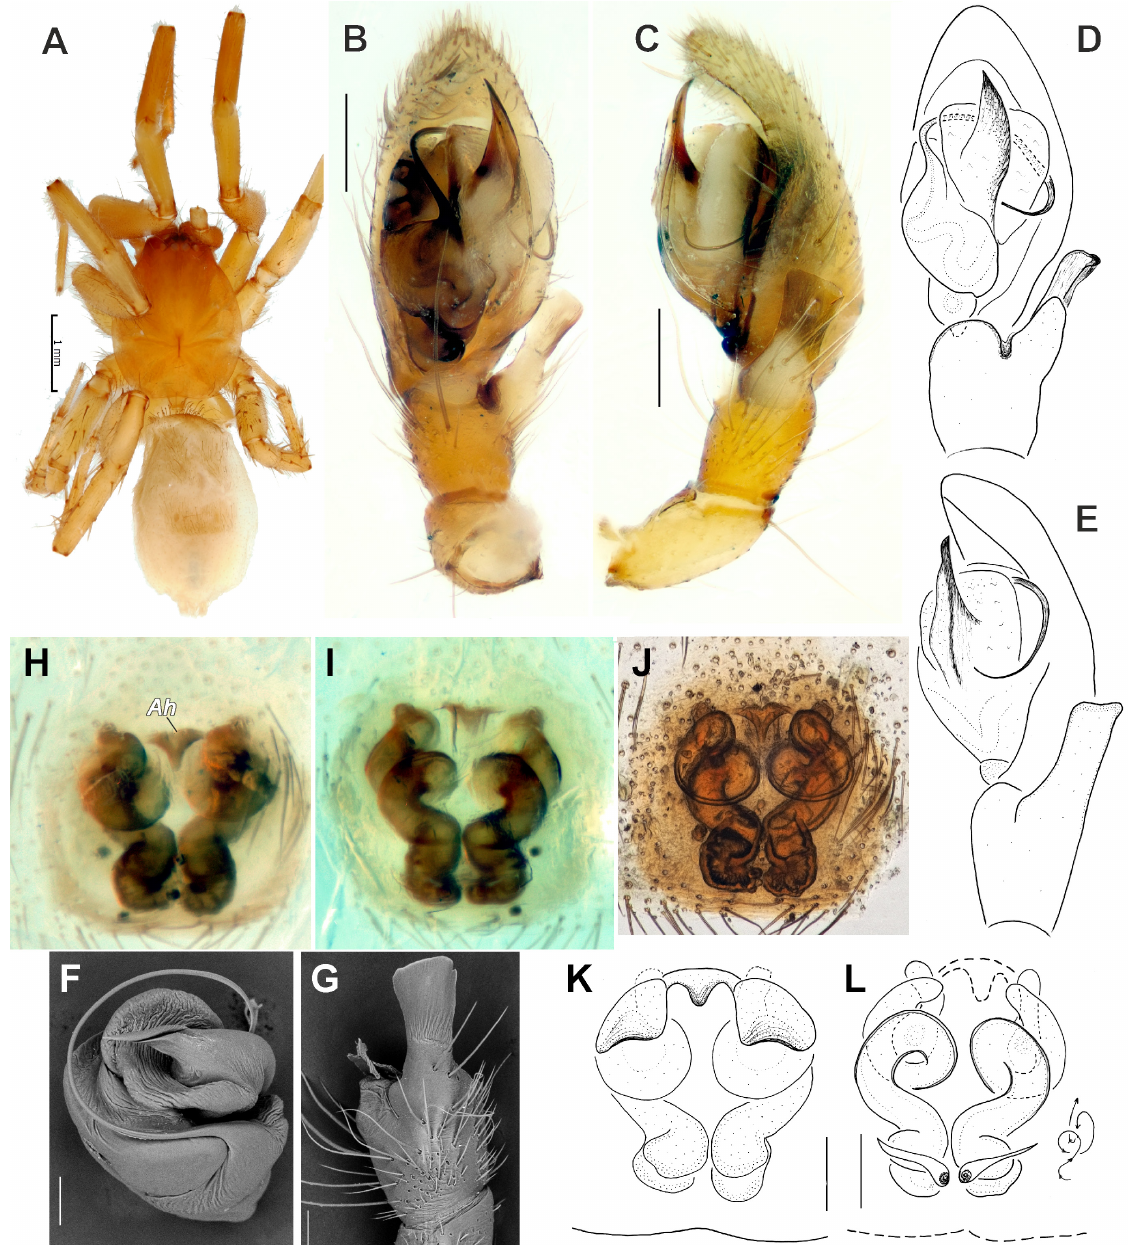
Fig. 2. Berinda hoerwegi sp. nov. (A–E = holotype, ♂, MHNG; F–G = paratype, ♂ from Kermanshah Provinve, MHNG ; H–L = paratype, ♀ from Ilam Province, MHNG). A . Habitus, dorsal view. B–E . Palp, ventral, retrolateral and retroventral views. F . Apical portion of bulb. G . Tibial apophysis, retrolateral view. H, J–K . Epigyne, ventral view. I . Epigyne, dorsal view. L . Same, with schematic course of internal duct system. Abbreviation: Ah = anterior hood. Scale bars: A = 1 mm; B–C = 0.2 mm; F–G, K–L = 0.1